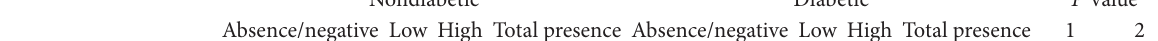
Table 2: Characteristics of the diabetic and nondiabetic vitrectomy samples.